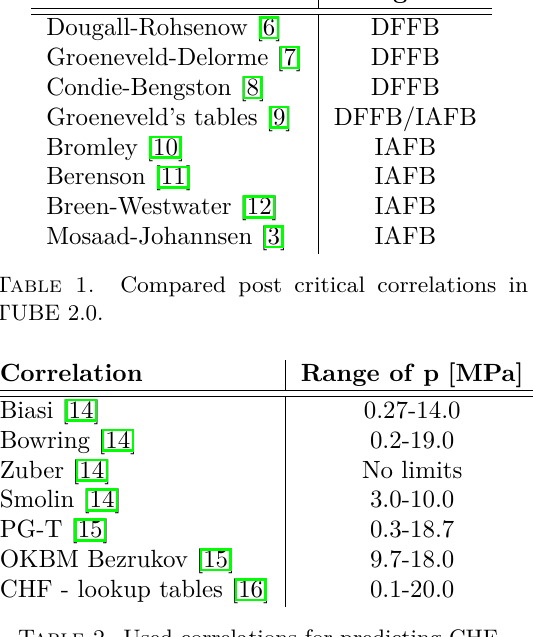
Table 2. Used correlations for predicting